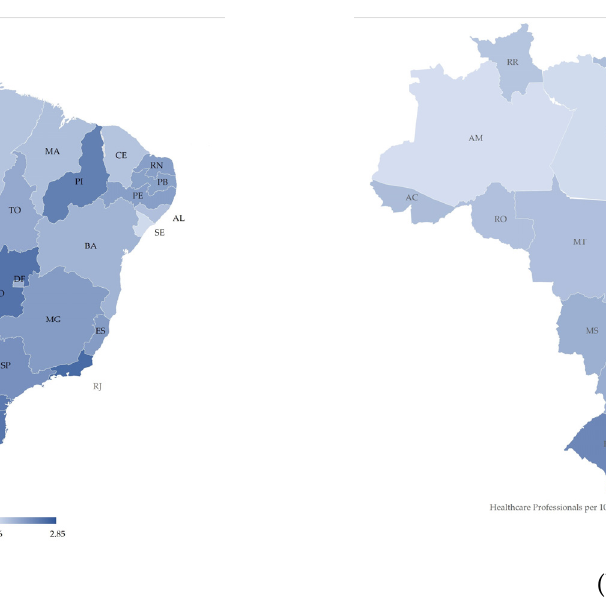
Figure 1. Map of Brazil, elaborated by the authors, with the distribution of healthcare resources by state: ( a ) Hospital Beds per 100,000 people ranging from 1.56 (light blue) to 2.66 (dark blue) ( b ) Healthcare Professionals (doctors and nurse) per 100,000 people ranging from 1.4 (light blue) to 5.69 (dark blue). Brazilian states acronym are: Acre (AC), Alagoas (AL), Amapá (AM), Amazonas (AP), Bahia (BA), Ceará (CE), DistritoFederal (DF), EspíritoSanto (ES), Goiás (GO), Maranhão (MA), MatoGrosso (MT), MatoGrossodoSul (MS), MinasGerais (MG), Pará (PA), Paraíba (PB), Paraná (PR), Pernambuco (PE), Piauí (PI), RiodeJaneiro (RJ), RioGrandedoNorte (RN), RioGrandedoSul (RS), Rondônia (RO), Roraima (RR), SantaCatarina (SC), SãoPaulo (SP), Sergipe (SE) and Tocantins (TO).